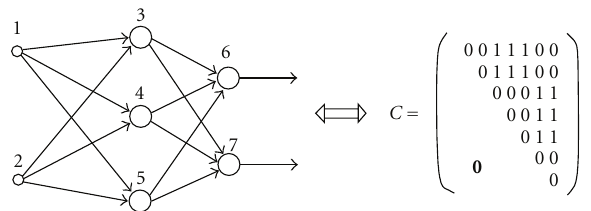
Figure 1: Direct encoding of a 2-2-1 FNN architecture. The number above each node denotes the cardinal of the